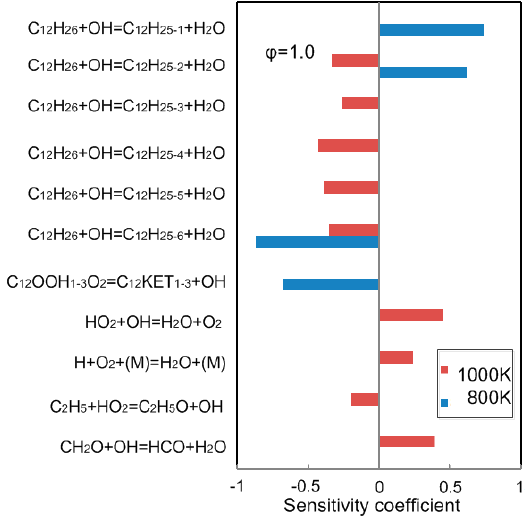
Figure 8. Sensitivity coe ffi cient of ignition delay time at P = 2.0 MPa and ϕ = 1.0, calculated using detailed mechanism from Laurence Livermore National Laboratory (LLNL) [12].